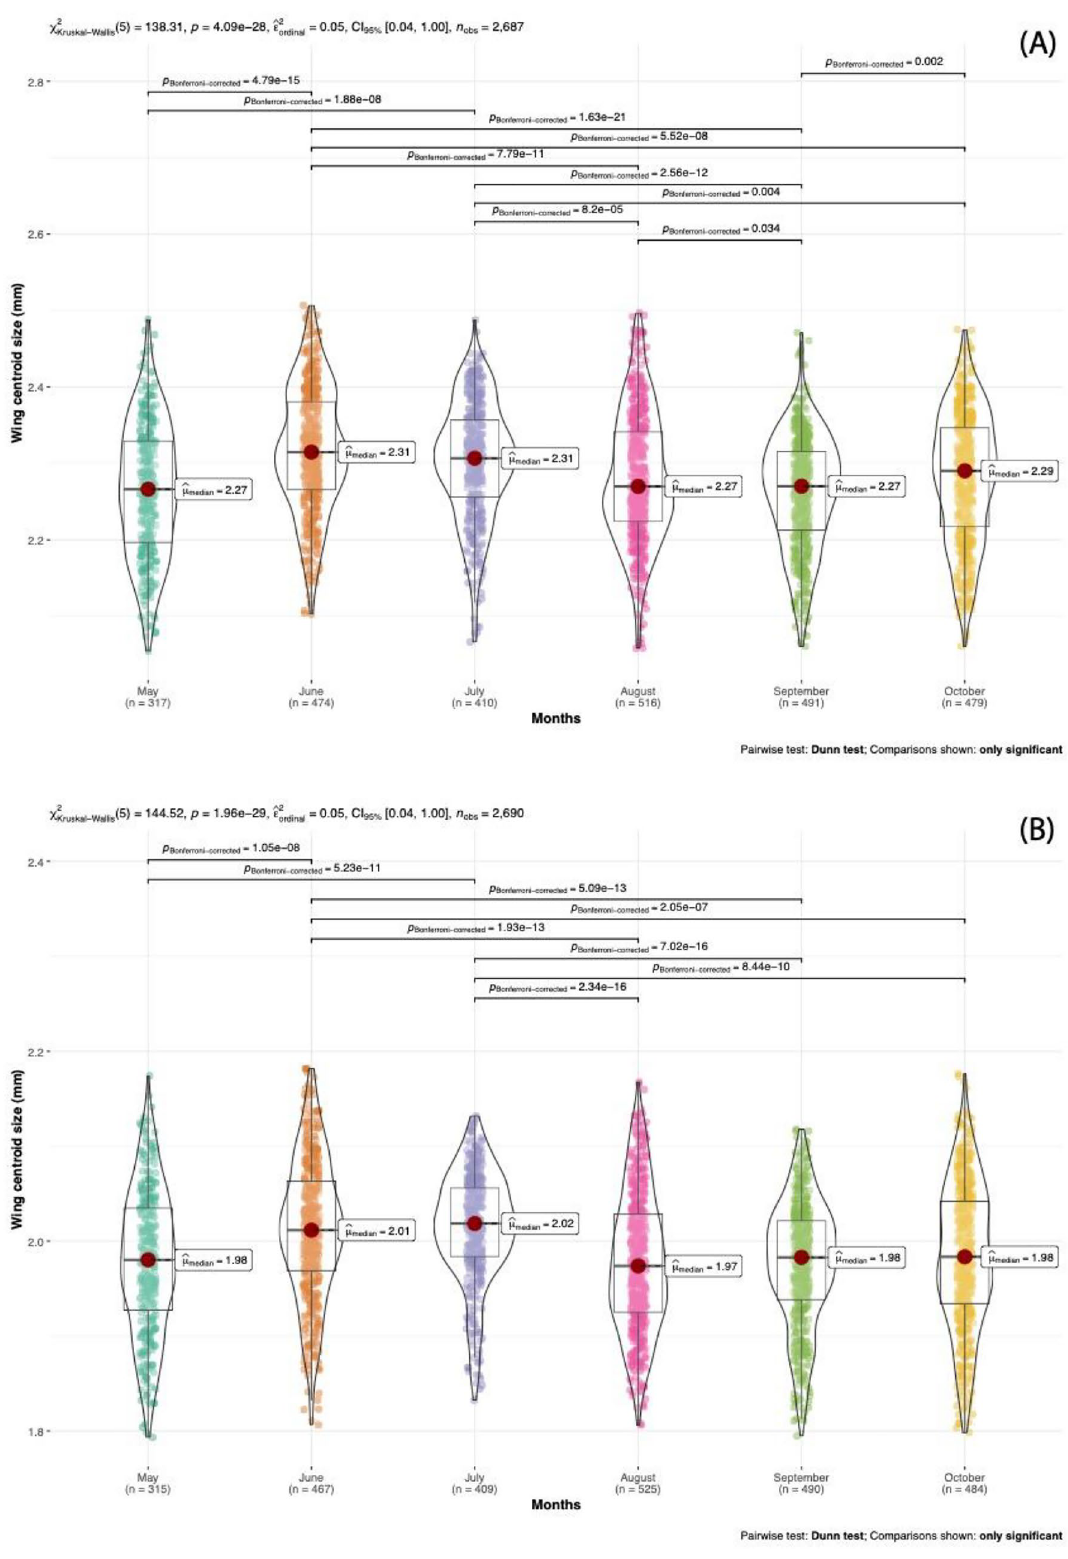
Figure 2. Wing centroid sizes for female ( A ) and male ( B ) by months. Wing centroid size difference among months was analyzed using Kruskal–Wallis test, followed by Dunn post-hoc test with Bonferroni